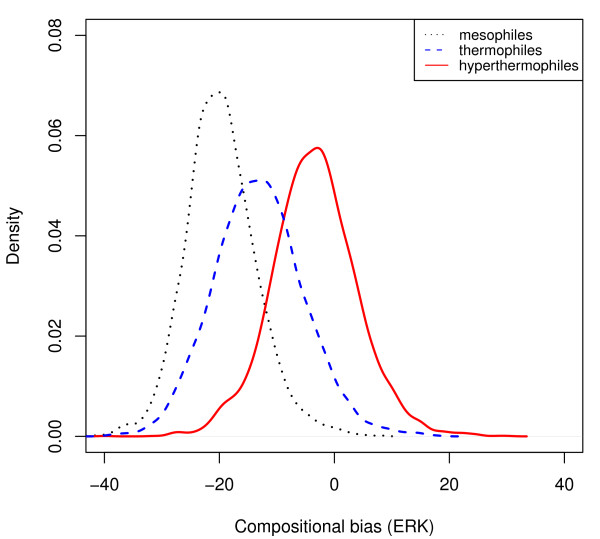
Amino acid usage differs between mesophilic, thermophilic and hyperthermophilic prokaryotes. Distribution of amino acid usage bias, ERK, across orthologous proteins for 5 species each of hyperthermophilic (optimal growth temperature ≥80° Celsius), thermophilic (50-80°), and mesophilic (≤50°) prokaryotes. All pairwise comparisons are statistically highly significant (Wilcoxon rank sum tests: p < 10-15). See Additional file 1: Supplemental Figure S3 for a correlated alternative measure of amino acid usage bias. Black: mesophiles; blue: thermophiles; red: hyperthermophiles.